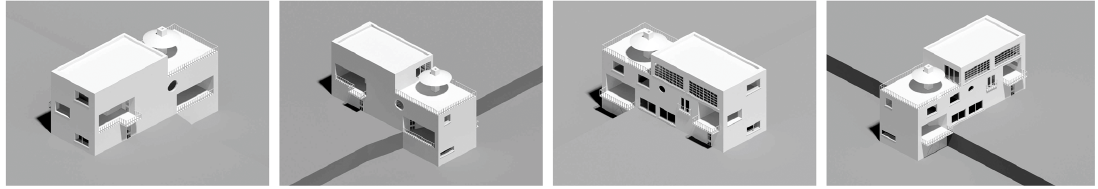
Figure 11. House 8. Axonometric views (C.